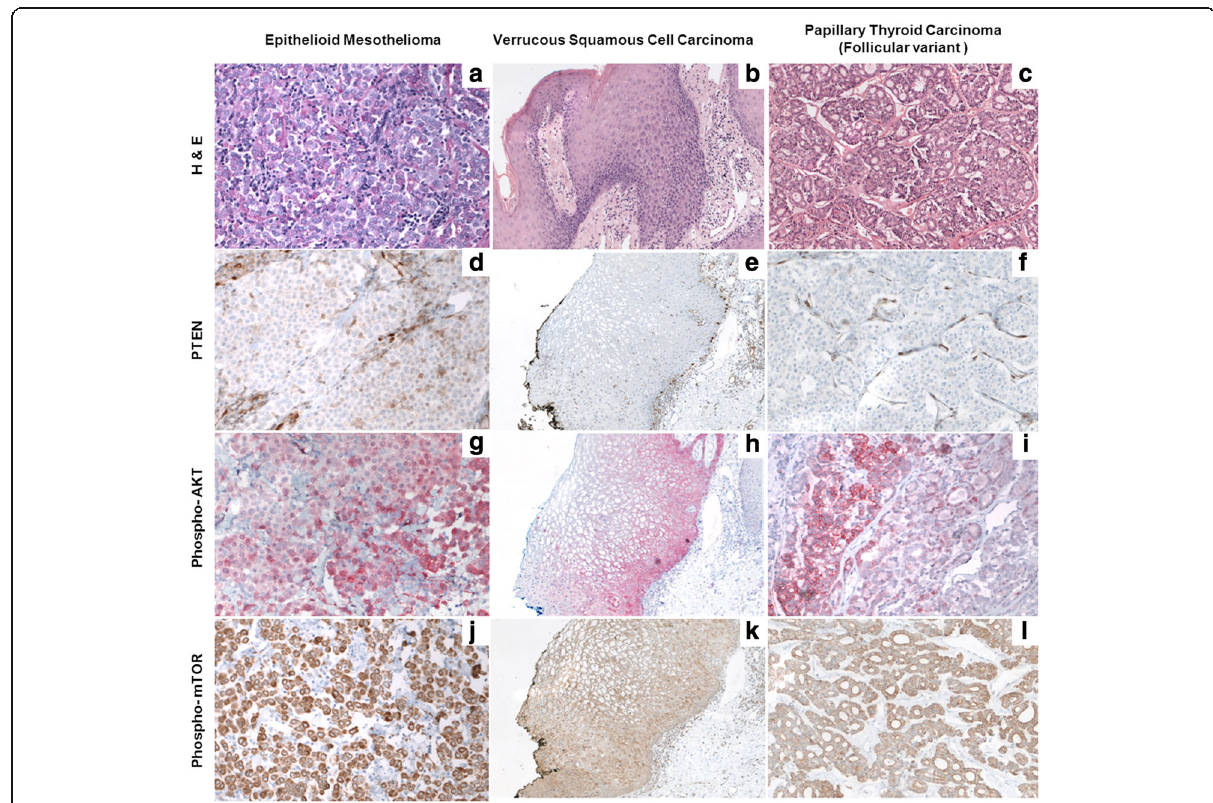
Fig. 2 PTEN, Phospho-AKT and Phospho-mTOR staining. H&E staining: epithelioid peritoneal mesothelioma (MPM) ( a ), verrucous (squamous cell) carcinoma (VC) ( b ), and papillary thyroid carcinoma ( c ). PTEN: Staining of respective tumors (stromal cells and vascular structures may serve as positive internal control) ( d , e , and f ). Phospho-AKT: immunostaining of respective tumors ( g , h , and i ). Phospho-mTOR: strong cytoplasmic staining in the MPM ( j ), weak cytoplasmic staining in the VC ( k ), and moderate cytoplasmic staining in the thyroid carcinoma (l) ; (all magnifications: